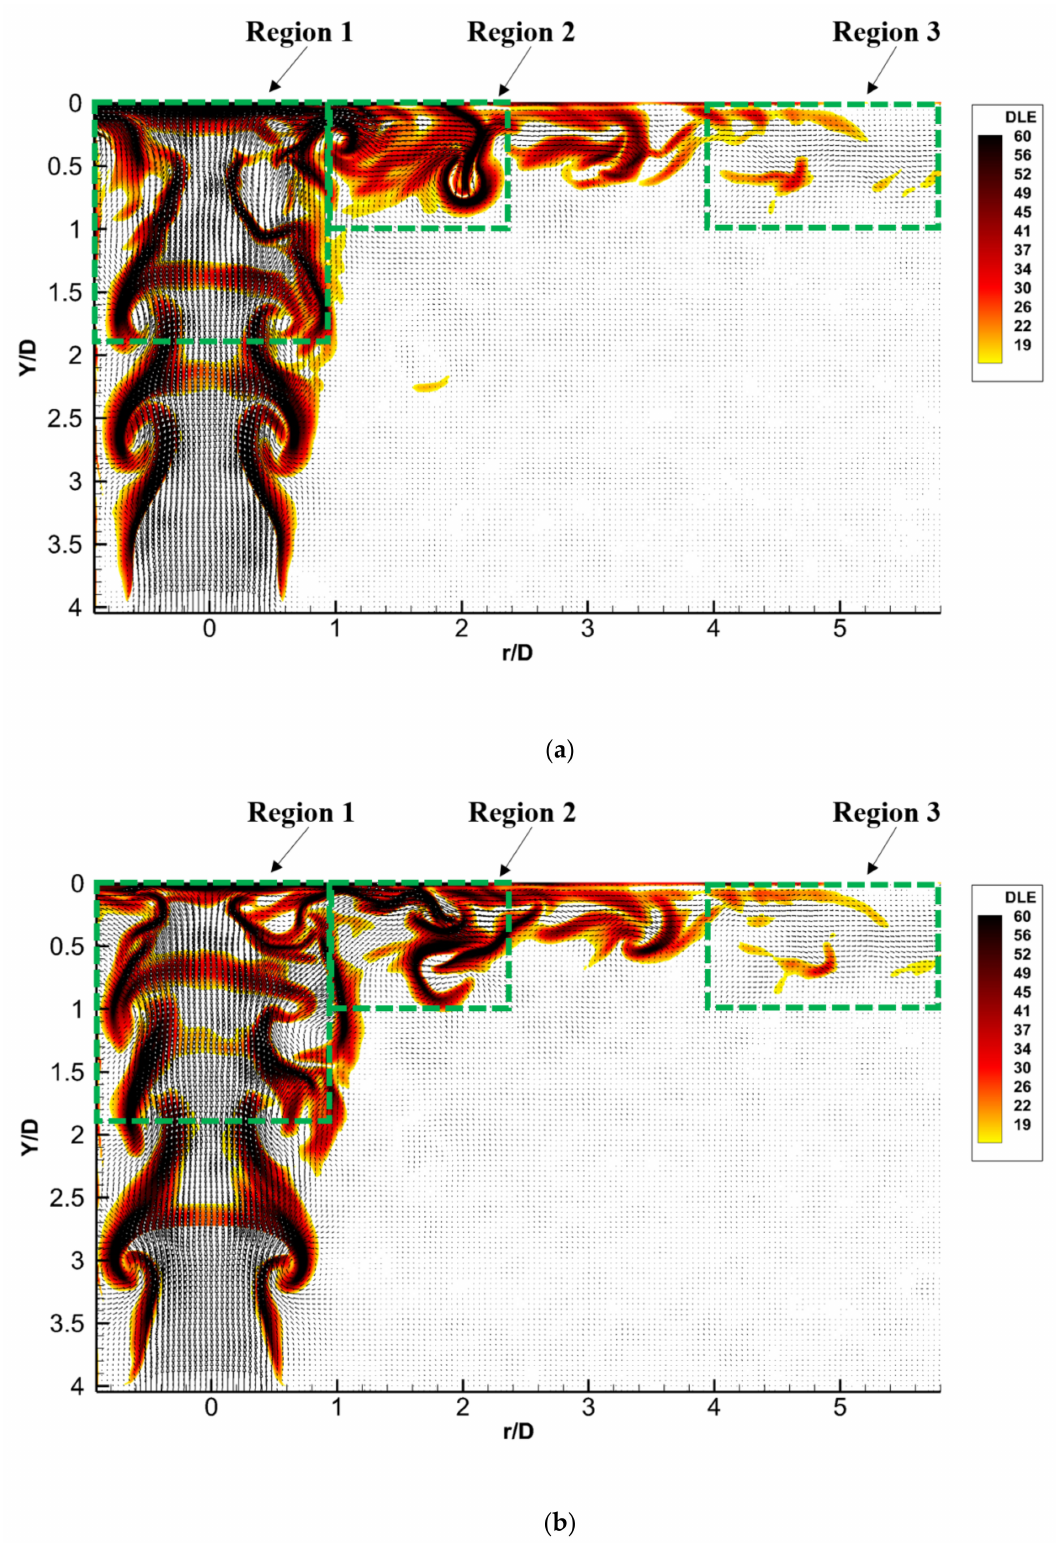
Figure 6. FTLE and velocity fields for the stationary case ( a ) t = t1 and ( b ) t = t1 + 30